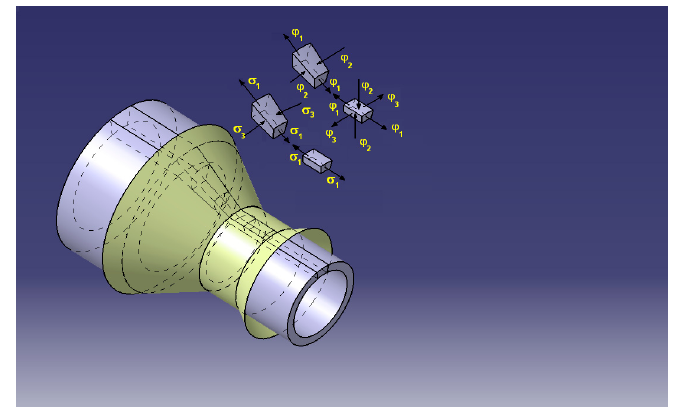
Figure 4. The stresses and strains during drawing without a mandrel.